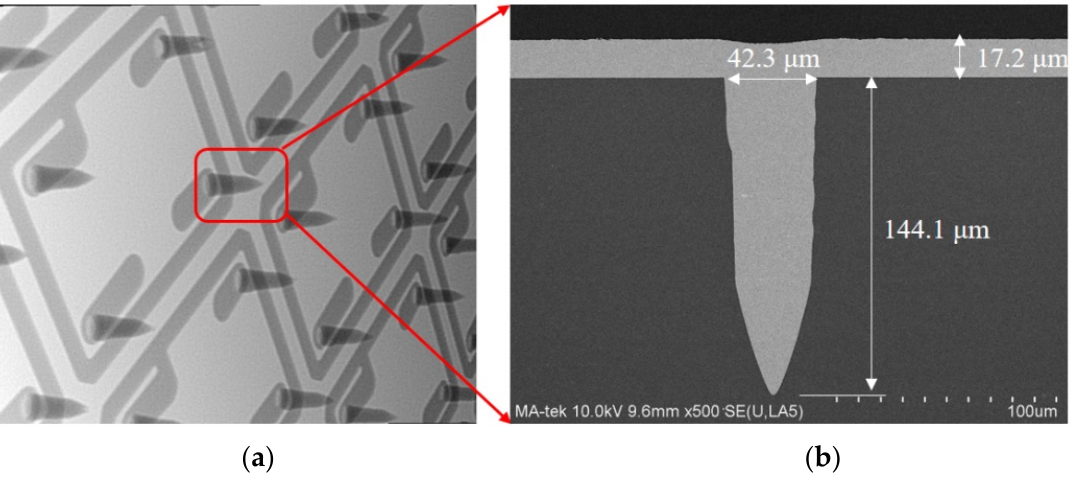
Figure 9. Metalized TGVs and X-ray images. ( a ) X-ray image. ( b ) Cross-sectional TGVs fully filled with Cu using bottom to up filling behavior with appropriate additive composition.